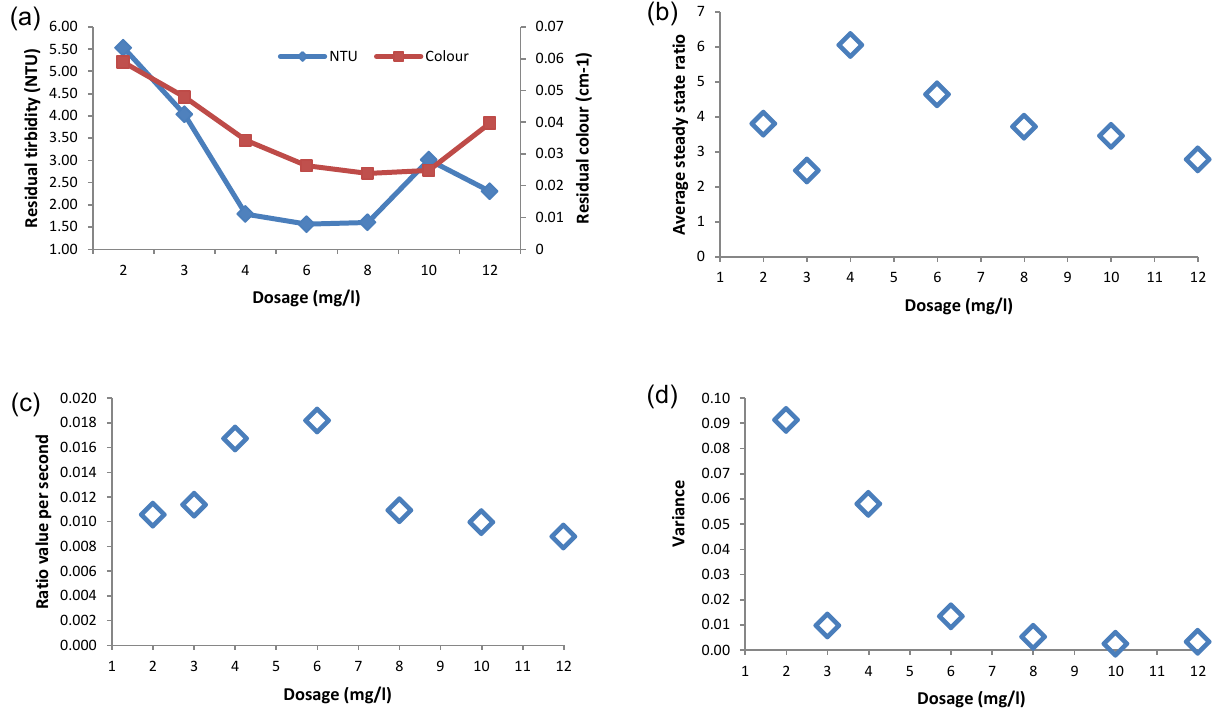
Figure 5. Optimization of dosage – (a) residual turbidity and colour; (b) average steady-state ratio; (c) aggregation rate; (d) steady-state variance